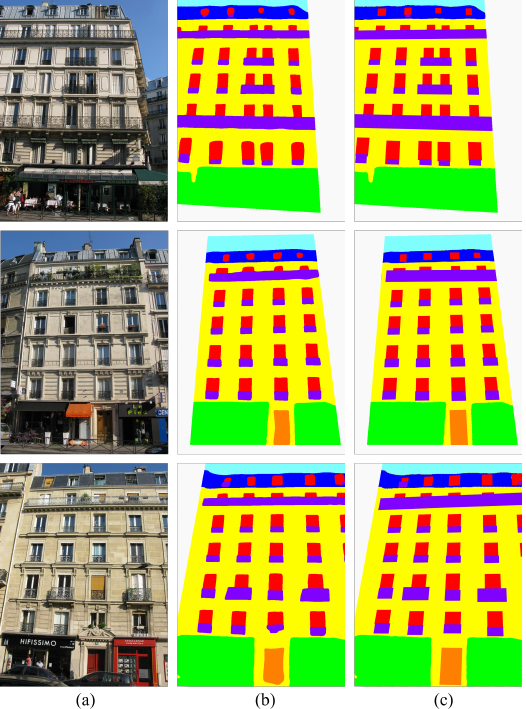
Figure 7. Visualization of fine-grained semantic segmentation on Dataset [38]. ( a ) Selected images from the dataset. ( b ) Results generated from the DeepLabv3+ [34] before Geometric-based Contour Optimization(GCO). After applying GCO, the final results are presented in ( c ). Compared with pixel-wise segmentation result, the edges of the segmentation are more lightweight and smoother after